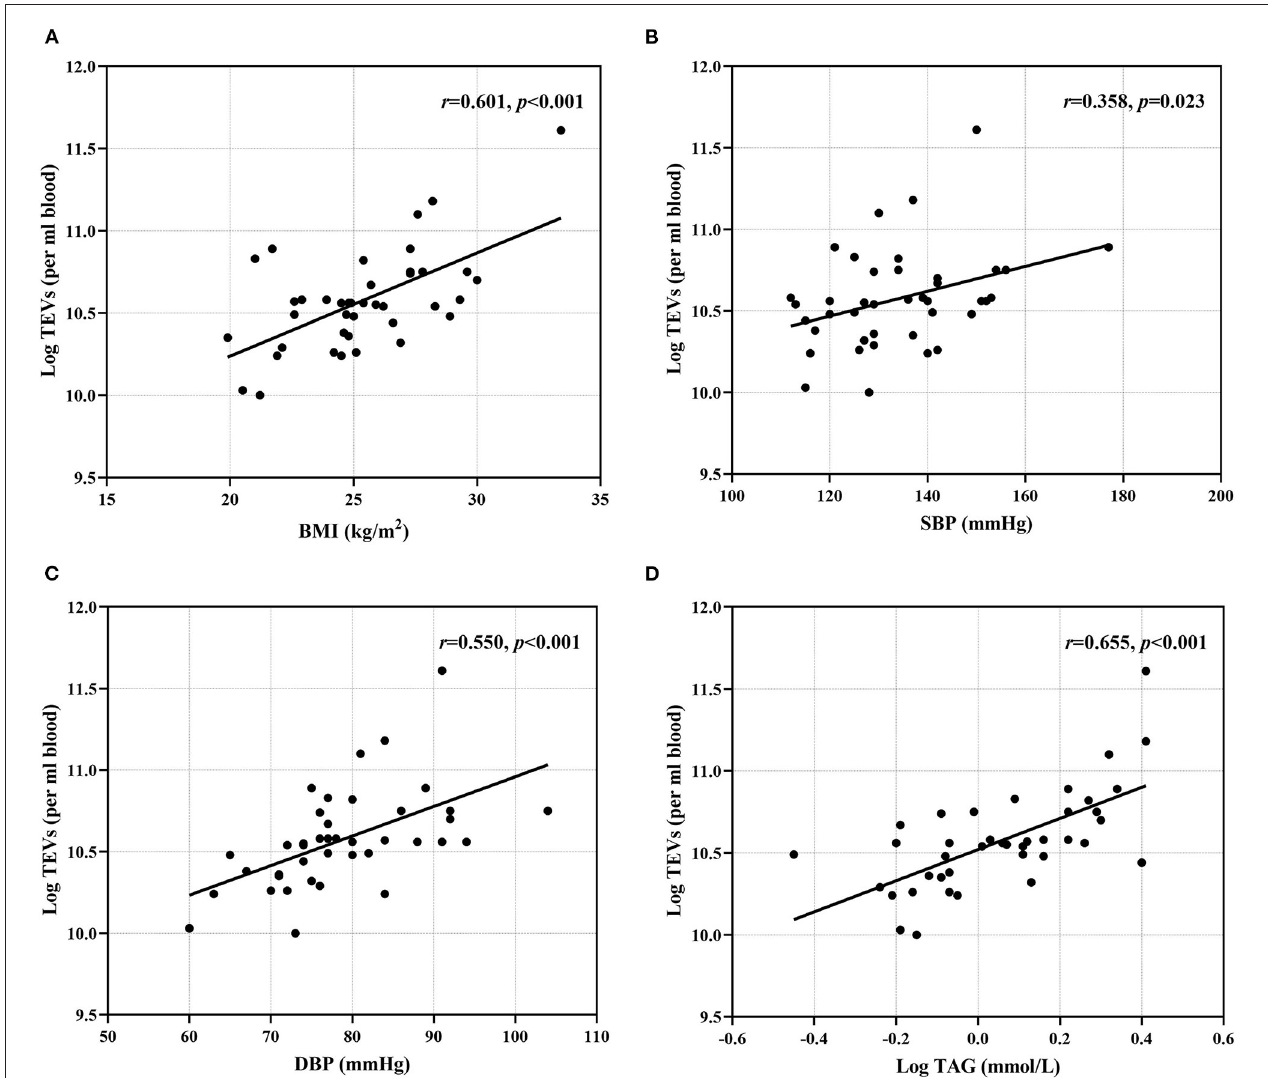
FIGURE 1 | Associations between conventional risk markers and EV numbers . (A) BMI; (B) SBP; (C) DBP and (D) plasma TAG were positively correlated with TEV numbers. BMI, body mass index; DBP, diastolic blood pressure; SBP, systolic blood pressure; TAG, triacylglycerol; TEVs, total extracellular